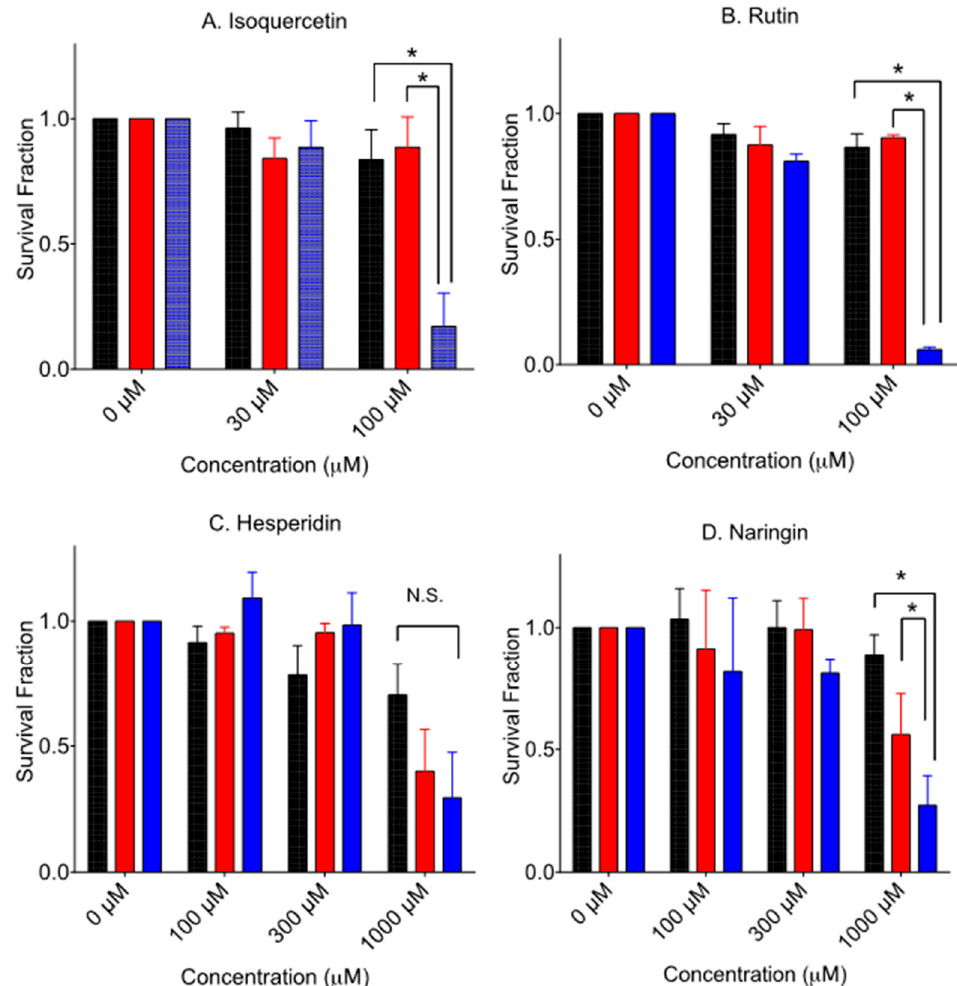
Figure 4. Cytotoxicity by aglycone form of flavonoids. Black bars indicate V79 cells. ( A ) isoquercetin, ( B ) rutin, ( C ) hesperidin, and ( D ) naringin. Red bars indicate V-C8 gene-corrected cells. Blue bars indicate V-C8 BRCA2-deficient cells. Mean values and standard error of the means from at least three independent experiments are plotted. * Indicates statistically significant differences ( p < 0.05). N.S. means no significant differences.